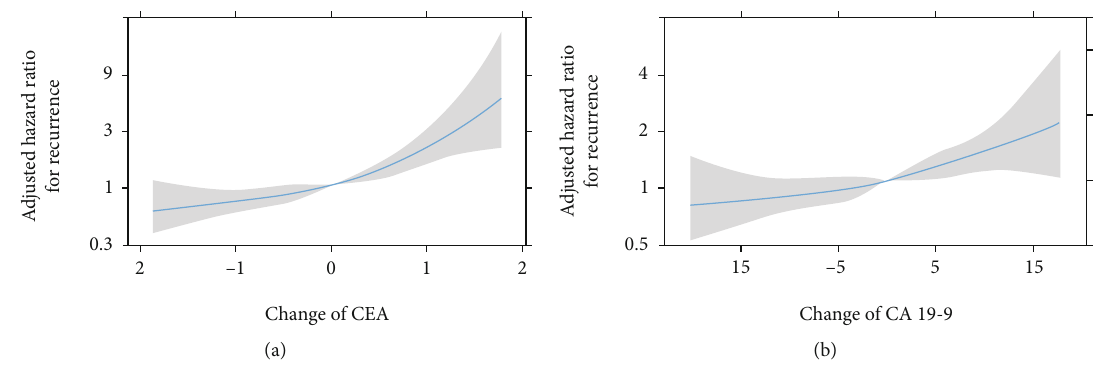
Figure 2: Recurrence hazard ratio (HR) adjusted for variations in CEA/CA 19-9 expression pro fi les. (a) HR adjusted for variations in CEA level. (b) HR adjusted for CA 19-9 level